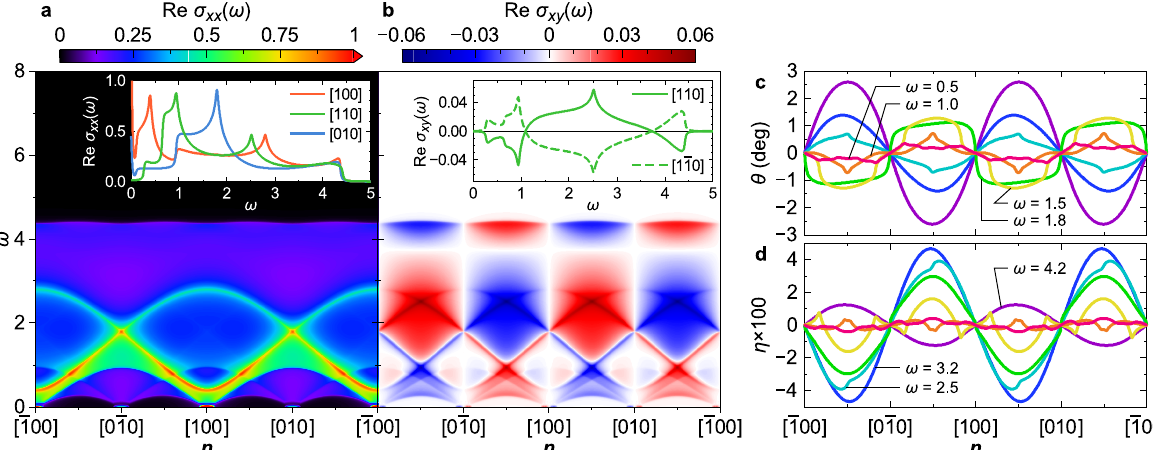
Fig. 4 Optical conductivity and magneto-optical effect. a , b Real parts of ( a ) longitudinal and ( b ) transverse optical conductivities. Energy ω and optical conductivity σ are shown in units of h 1 = 1 eV and e 2 /( ħ a ) = 6.4 × 10 3 S cm − 1 , respectively. Insets in ( a ) and ( b ) show the optical conductivity for n ∥ [100], [110], [010], and ½ 110 (cid:4) . Panels c , d show the magneto-optical rotation angle θ and ellipticity η as functions of the in- plane angle of the Néel vector. The lattice constant and broadening factor are set to a = 0.38 nm and Γ / h 1 = 0.02,